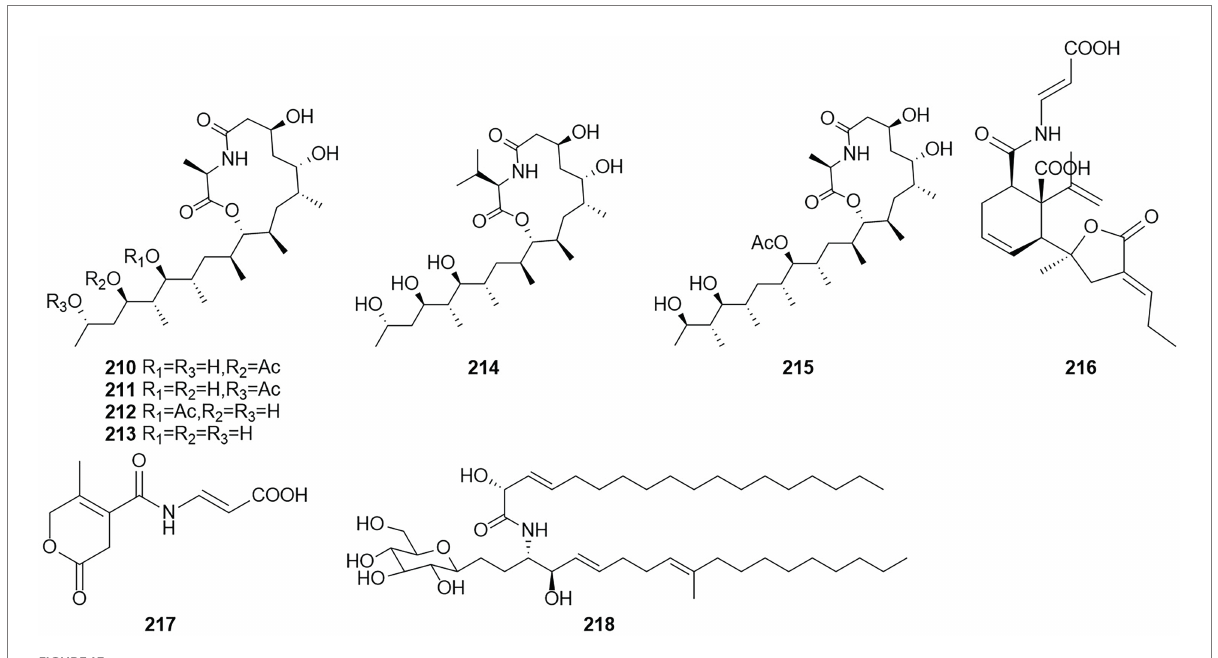
FIGURE 13 Chemical structures of compounds 210–218 .